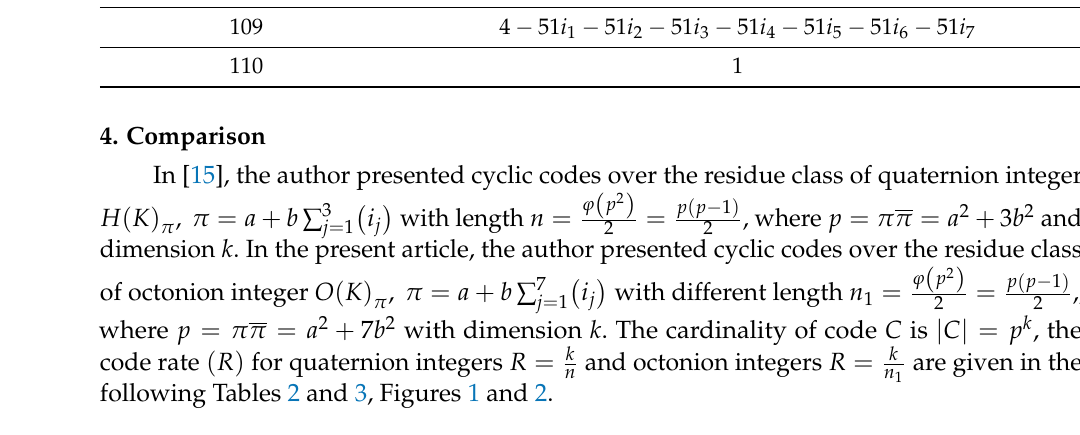
Table 2. Primes, length, cardinality, and code rate (R) of code over quaternion integers.